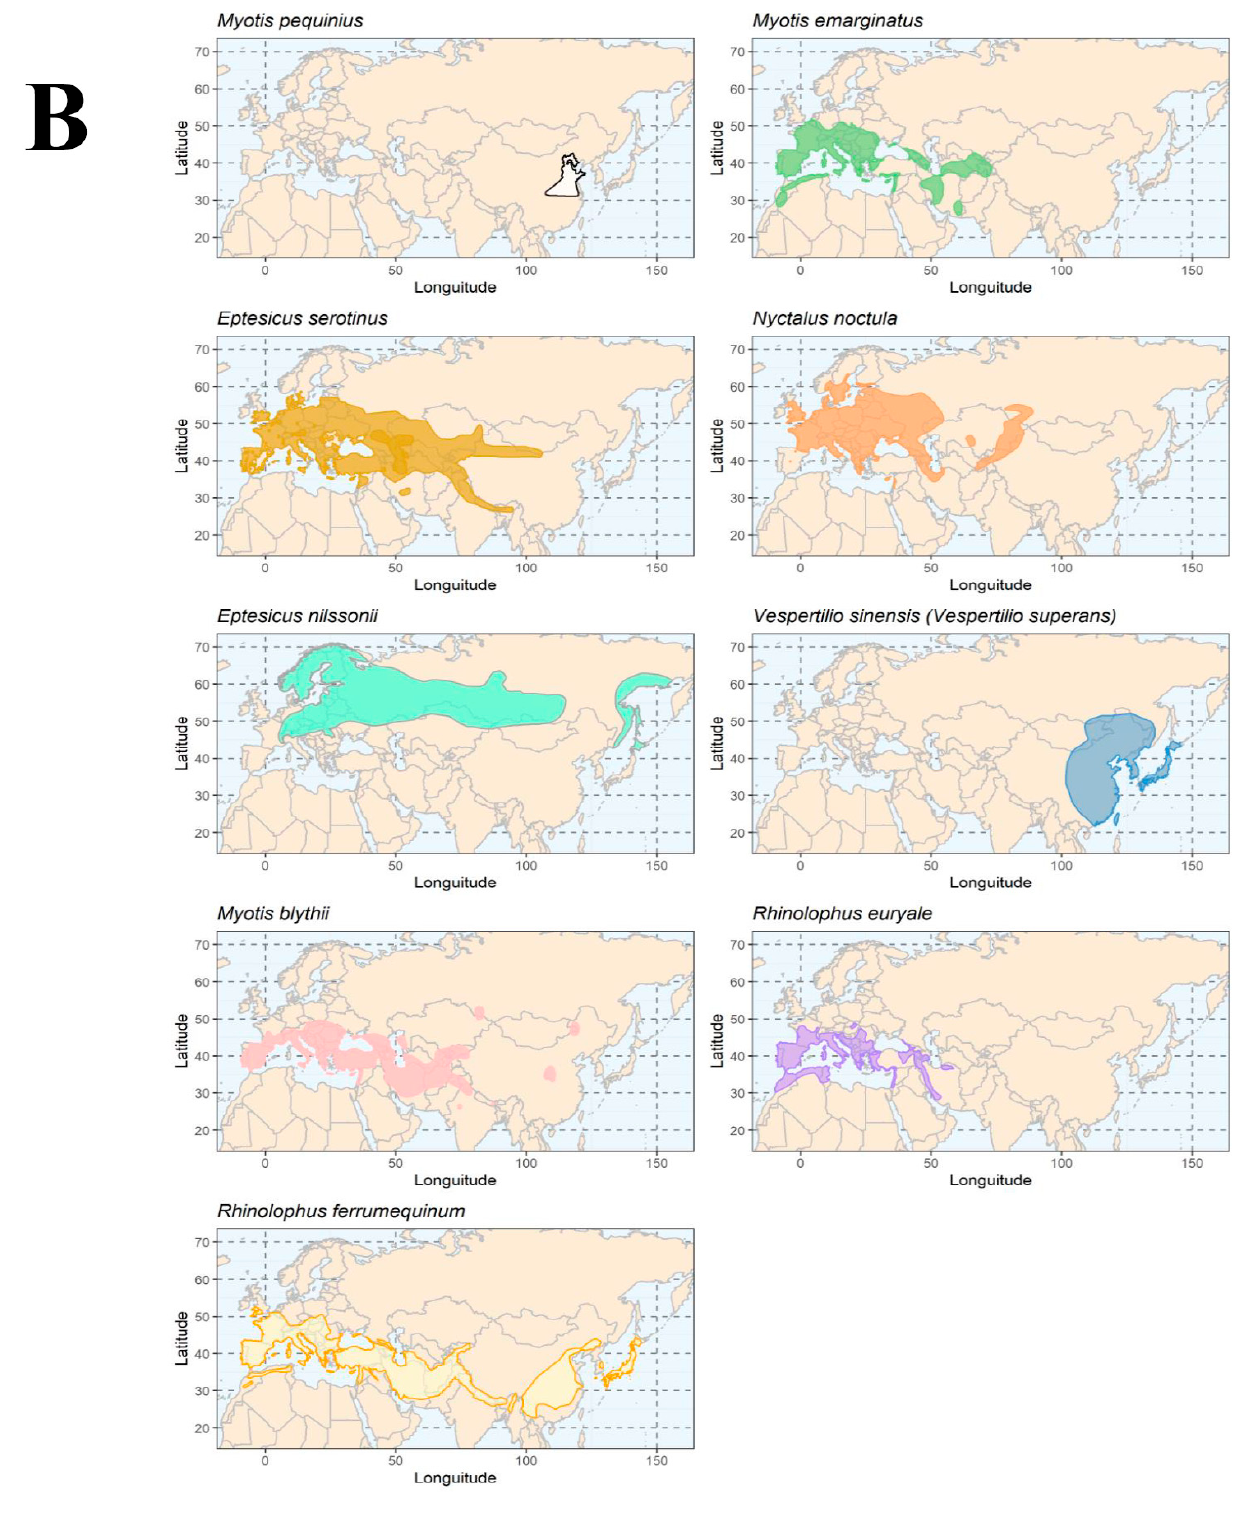
Figure 4. Distribution maps for bat species found to be CoV positive in this study compared with the geographic range of other bat species presenting highly similar CoVs across Eurasia as observed in our phylogenetic reconstructions. ( A ) de- picts the geographic range of bat species with highly similar AlphaCoV obtained from Georgia with those reported in other countries across Eurasia. ( B ) depicts the geographic range of bat species with highly similar BetaCoV obtained from Georgia with those reported in other countries across